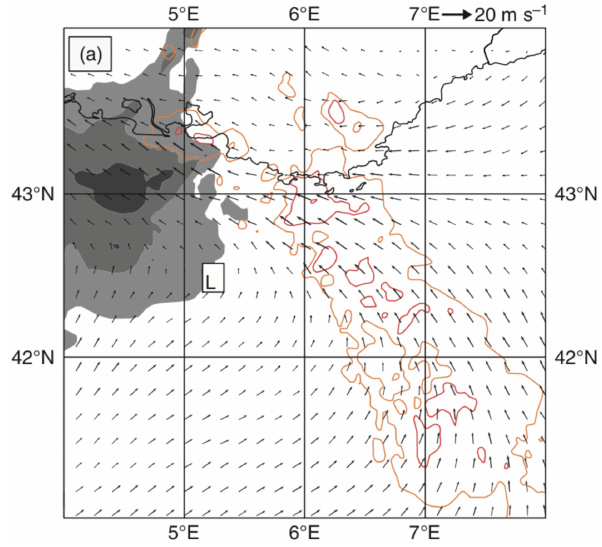
Figure 10. Lowest quartile of the mean sea level pressure (shading), mean 10m wind (arrows), and mean moisture flux at 925hPa (solid lines: 80 and 100gms − 2 ) valid at 12:00UTC on 26 October 2012 for the AROME-EPS ensemble (credit: Nuissier et al.,